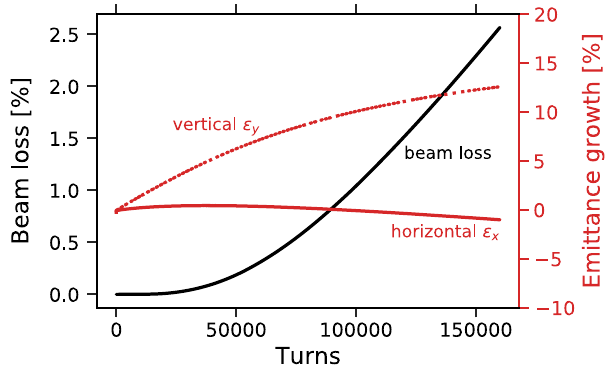
FIG. 11. High-resolution PIC results for the full field error model at working point Q x ¼ 18 . 97 , Q y ¼ 18 . 85 .